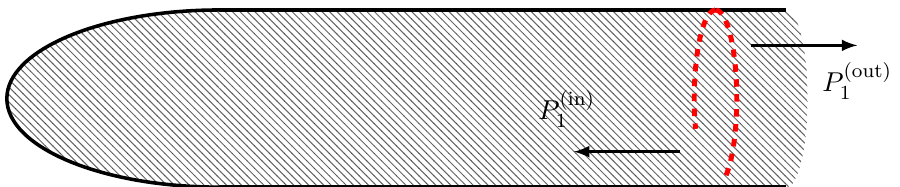
Figure 4 . The classical scattering problem in the cigar NLSM. From the asymptotically (cid:13)at domain the string approaches the tip, scatters and then escapes back to the (cid:13)at region. After the scattering process the zero mode momentum changes